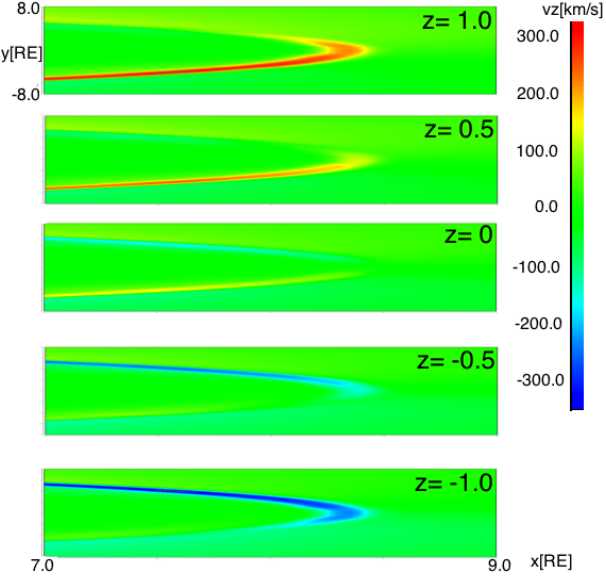
Fig. 3. Velocity in the z direction for z cuts ( z = + 1, + 0.5, 0, − 0.5, − 1 R E ) on the x - y plane. The blue (red) region shows the flow di- rection roughly to south (north). The X line is located at the point of flow reversal.